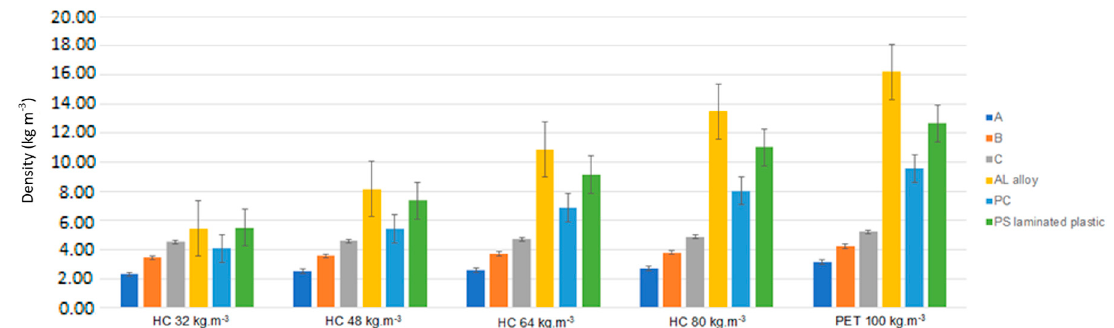
Figure 3. Mass balance of tested constructions. A comparison with other materials used in the sphere of production of transport means.